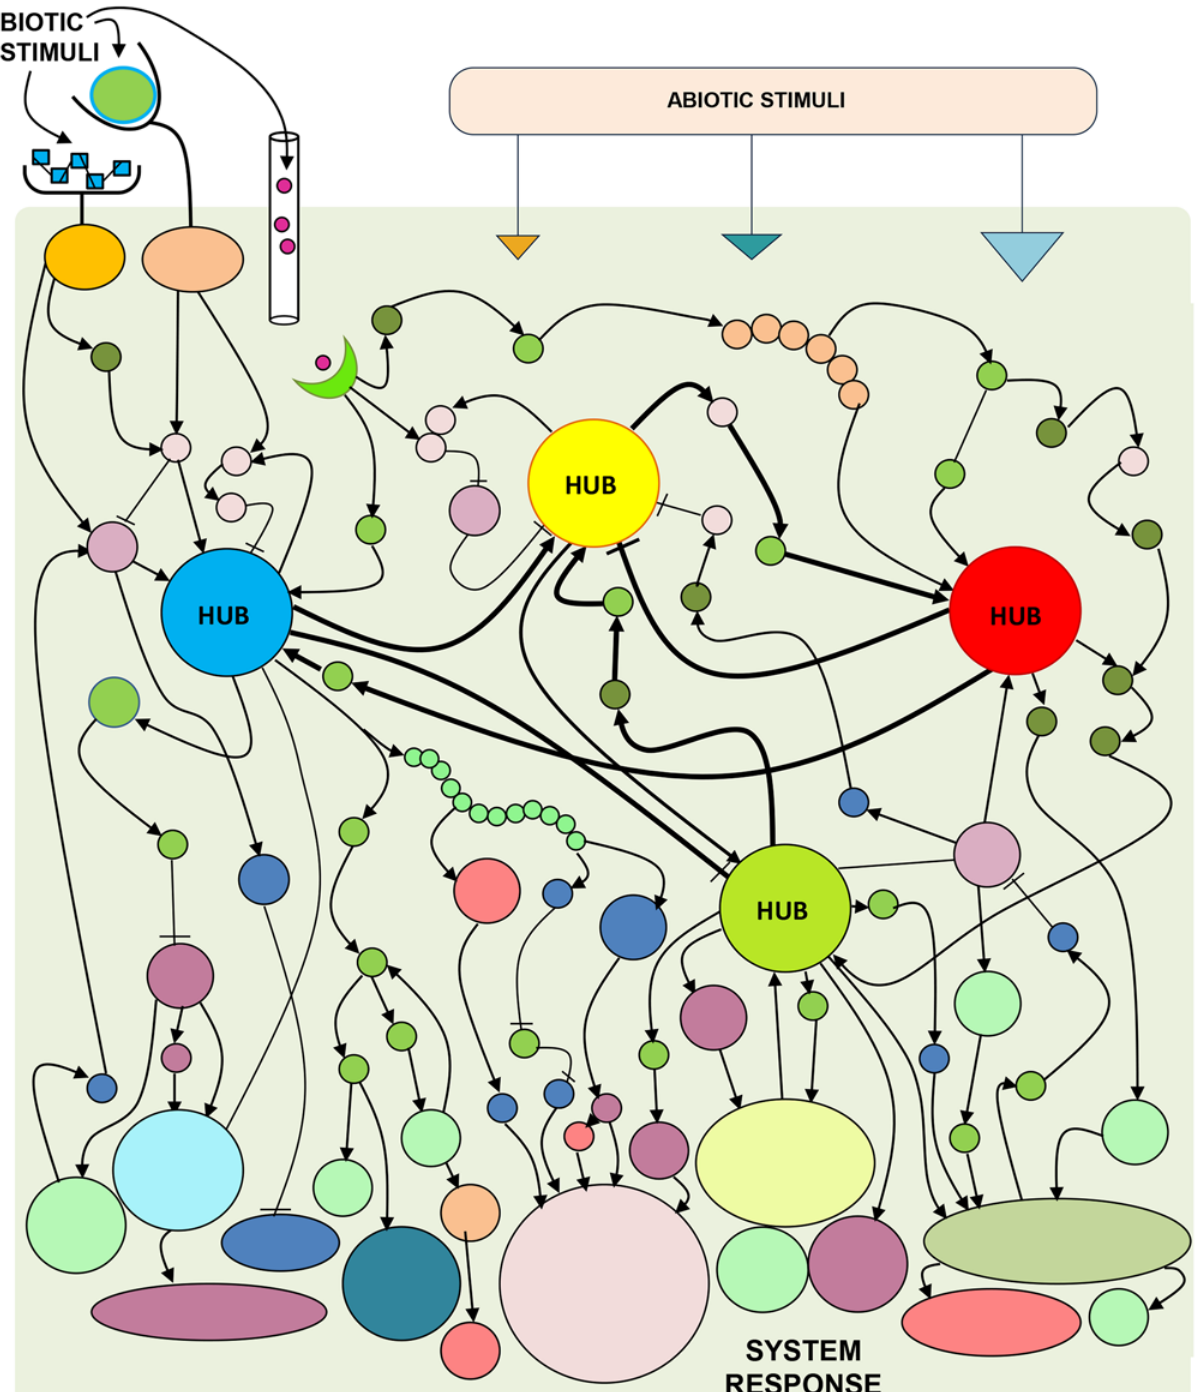
Fig 1. Combinations of system perturbations assist in discovering the mechanisms that drive complex biological system responses. Complex systems, e,g., the immune system of an organism, are notably complicated in two ways: (1) they are tuned to respond differently to different system inputs, and (2) the system that mediates outputs as a function of inputs is full of network redundancy, which ensures operation under nonideal circumstances. Thus, learning the rules for how a complex system operates requires coincident, varied, and likely combinatorial external and internal perturbations to a system. Mild perturbations are likely buffered by the system; strong perturbations are the key. Complex systems often have numerous parts; how do we decide which parts should be perturbed? Network hubs — parts which integrate numerous signals and/or regulate many parts — are excellent candidates for an abbreviated